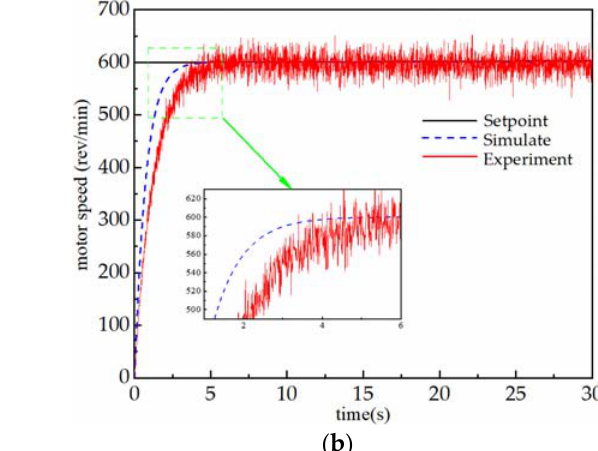
Figure 8. Step response curves under no − load condition. ( a ) Simulation results; ( b ) experimental results.